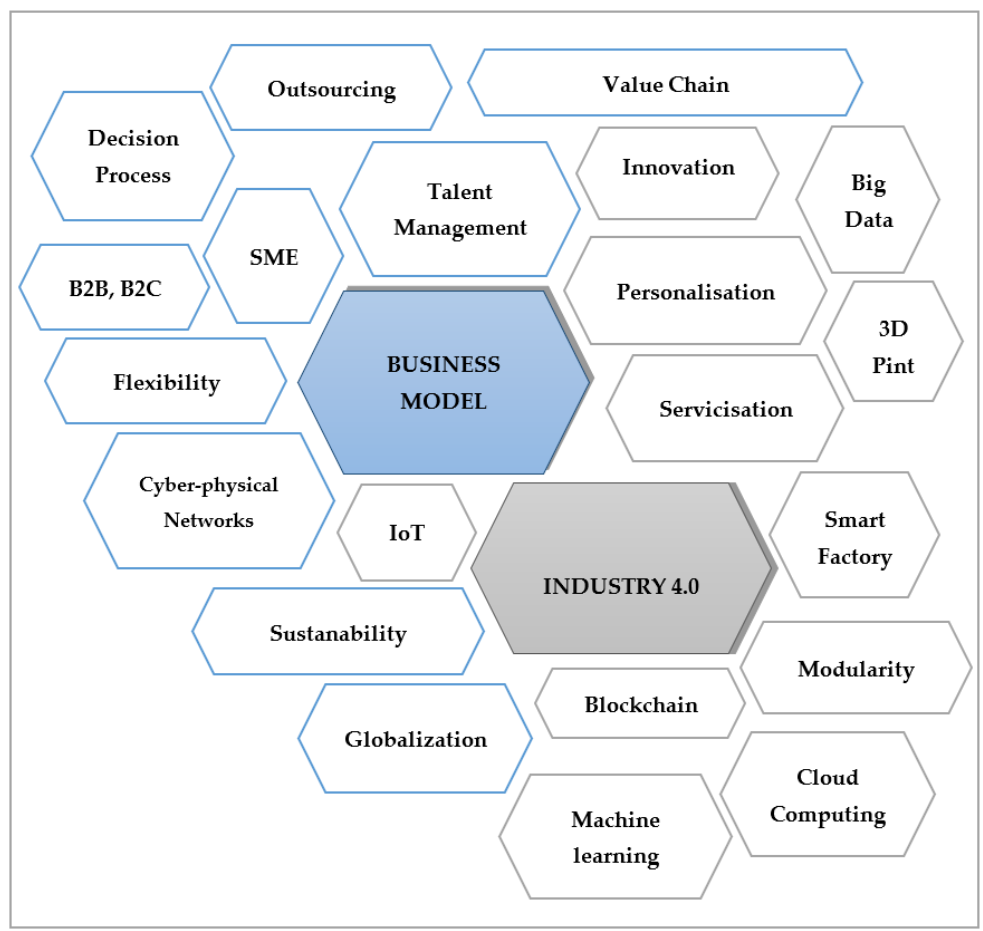
Figure 7. Pillar cluster of business models of enterprises in the Industry 4.0 era. Source: own elabo- ration.